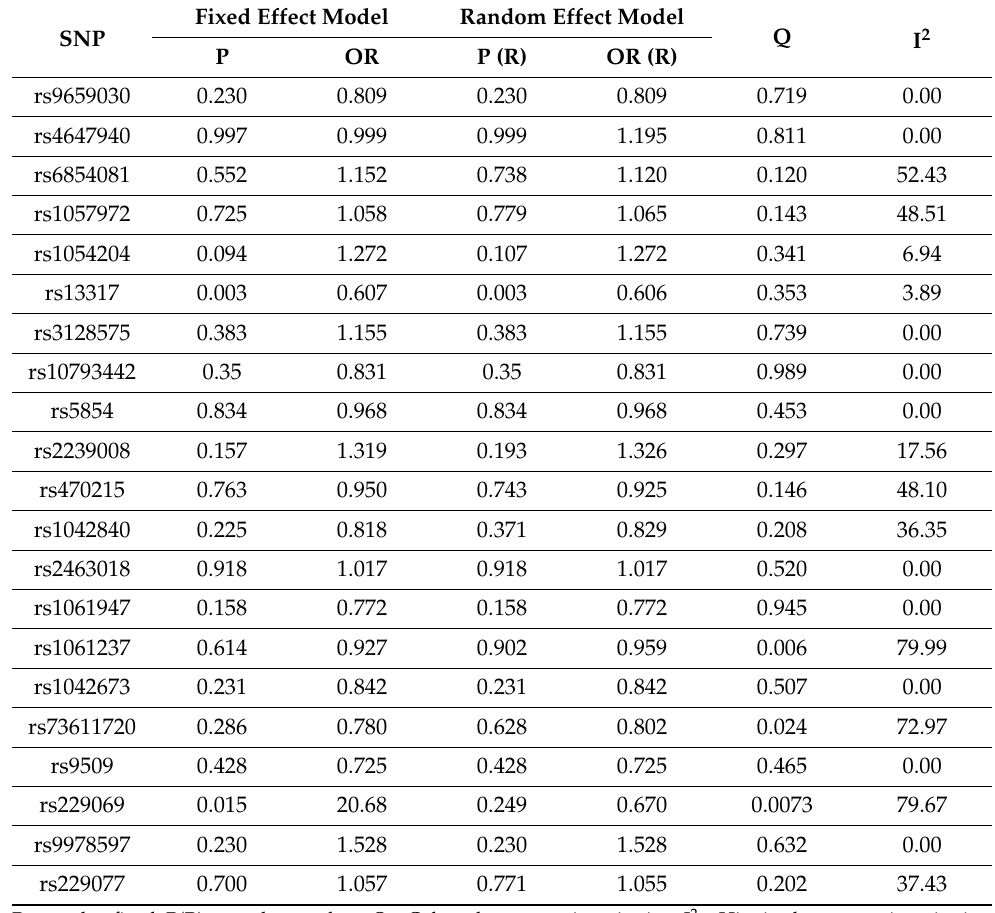
Table 5. Meta-analysis of microRNA target sites loci associations in patients with and without